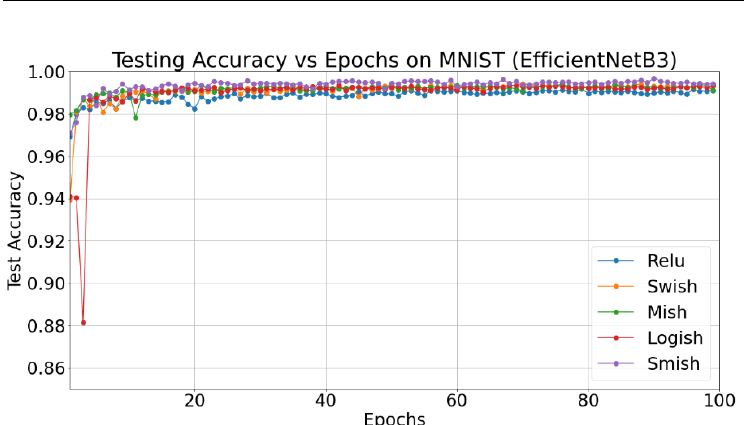
Figure 11. Accuracy vs. epochs in EfficientNetB3 achieved via the five activation functions on Mnist.